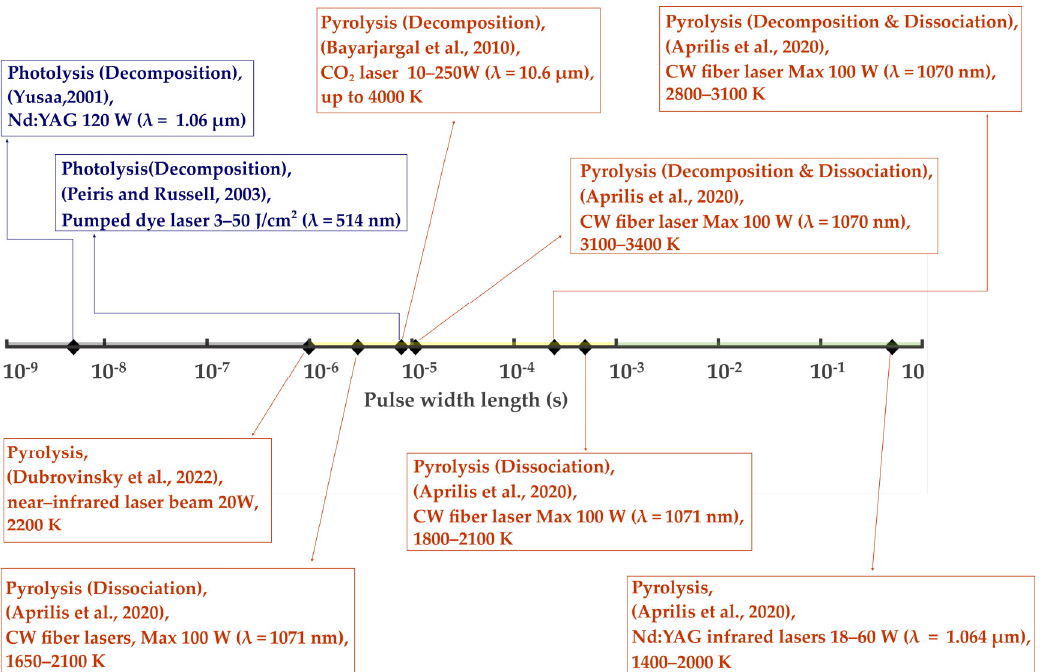
Figure 9. Classes of laser-induced reactions obtained (pyrolysis, photoexcitation, photolysis, etc.) vs. laser beam pulse widths employed, including Q-switched, electrooptically pulsed, and chopped beams [60,77,82–84,237].